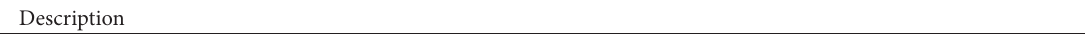
Table 3: Five objective